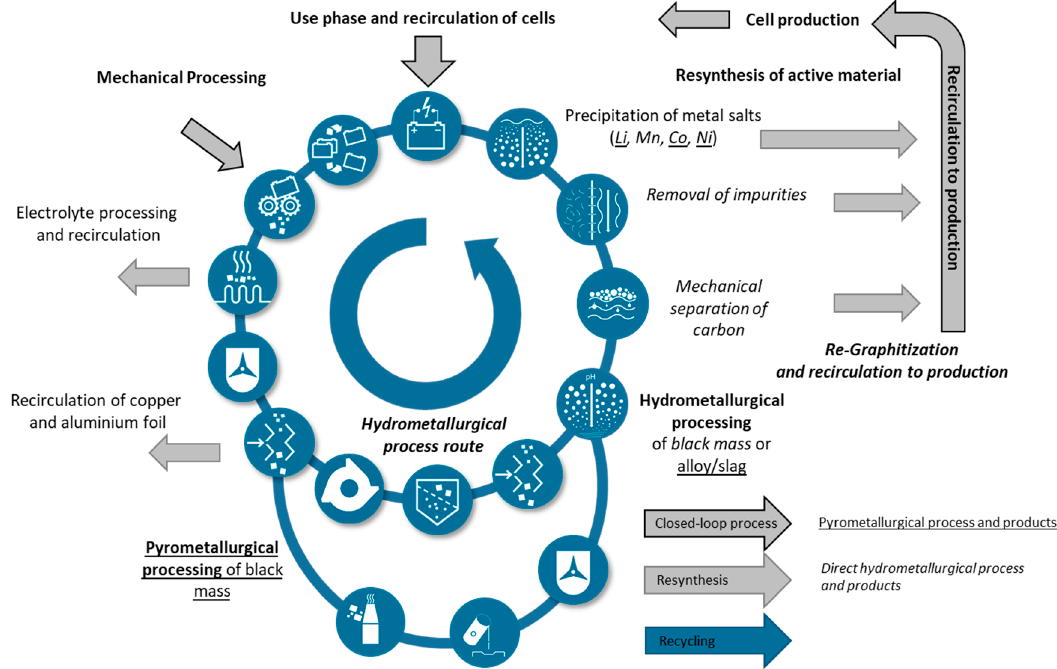
Figure 5. Exemplary approach for the cycle of circular battery production with the presentation of both established processing routes, direct hydrometallurgical and upstream pyrometallurgical processing after previous mechanical processing.